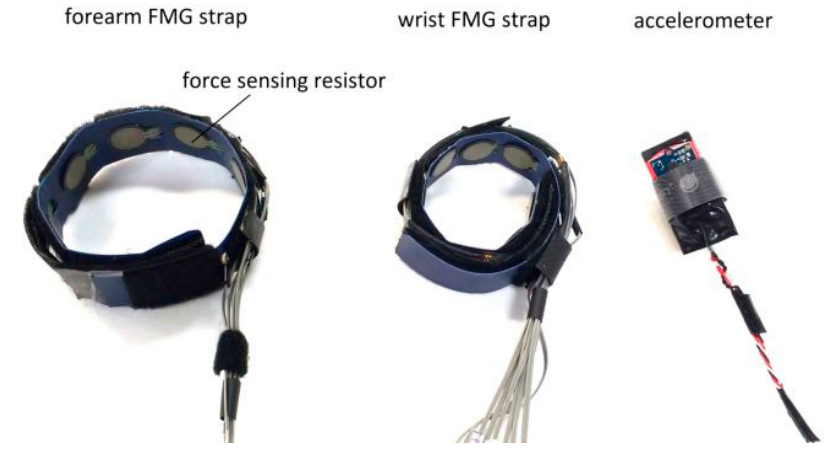
Figure 2. FMG and motion sensing devices.